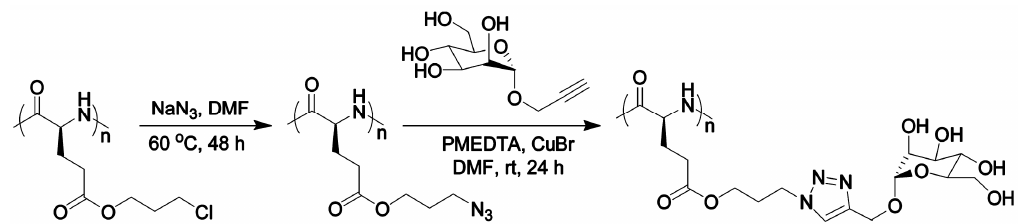
Figure 19. Post-modification of the side-functional groups to introduce Mannose. Reproduced with permission from reference